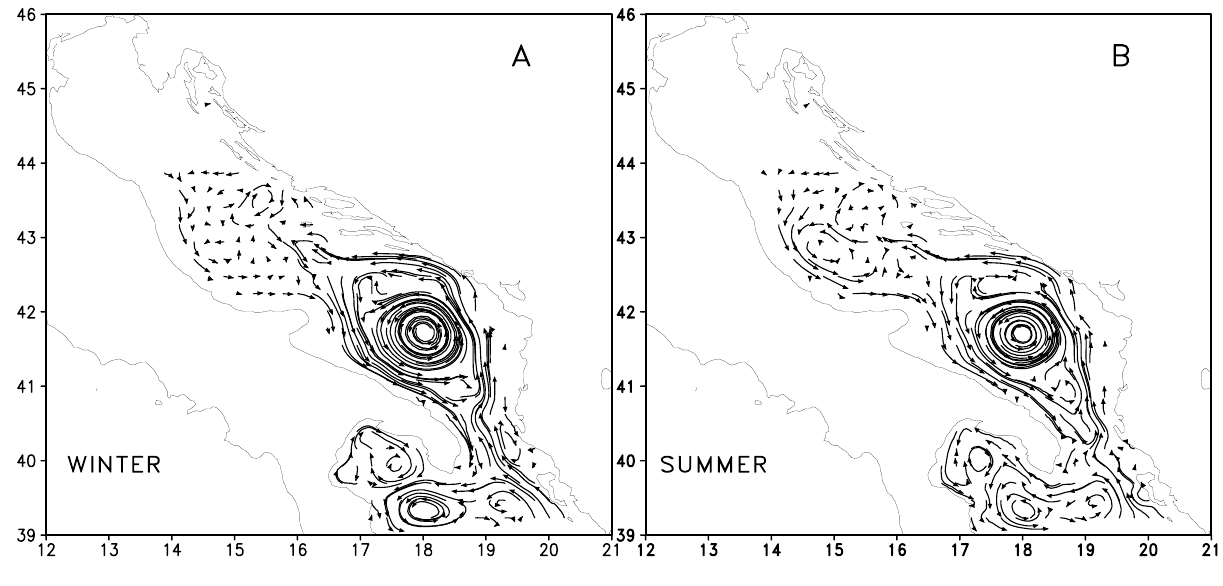
Fig. 7. Adriatic Intermediate Model (AIM). Seasonal surface salinity fields. (A) : winter, (B) : summer. Contour interval is 0.1psu. Seasons definition as in Artegiani et al. (1997a, b).